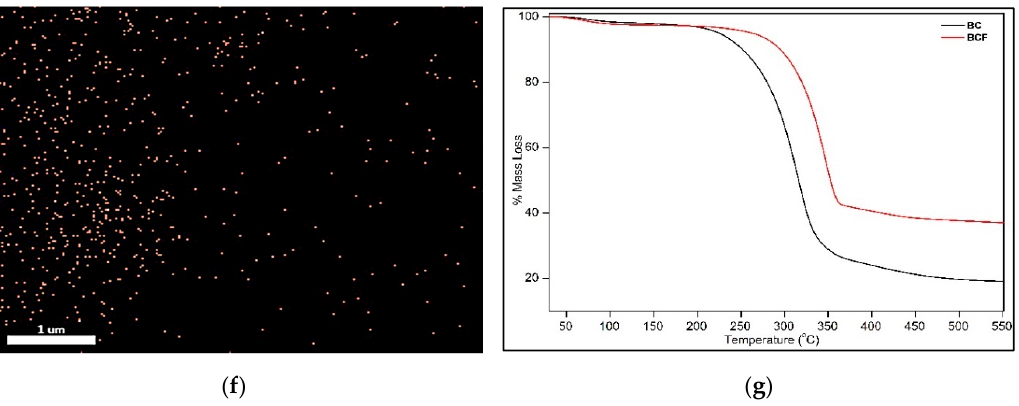
Figure 1. ( a ) FE-SEM micrographs of synthesized FeNPs, ( b ) EDS spectrum of FeNPs displaying elemental information (inset: point selected for EDAX), ( c ) FE-SEM micrograph of BC, ( d ) FE-SEM micrograph of synthesized BCF (FeNPs marked with white arrows), ( e ) EDS spectrum of BCF displaying elemental information, (inset. area selected on BCF specimen for EDS mapping; ( f ) EDS map of FeNPs on BCF surface and ( g ) TGA profiles of BC and BCF.